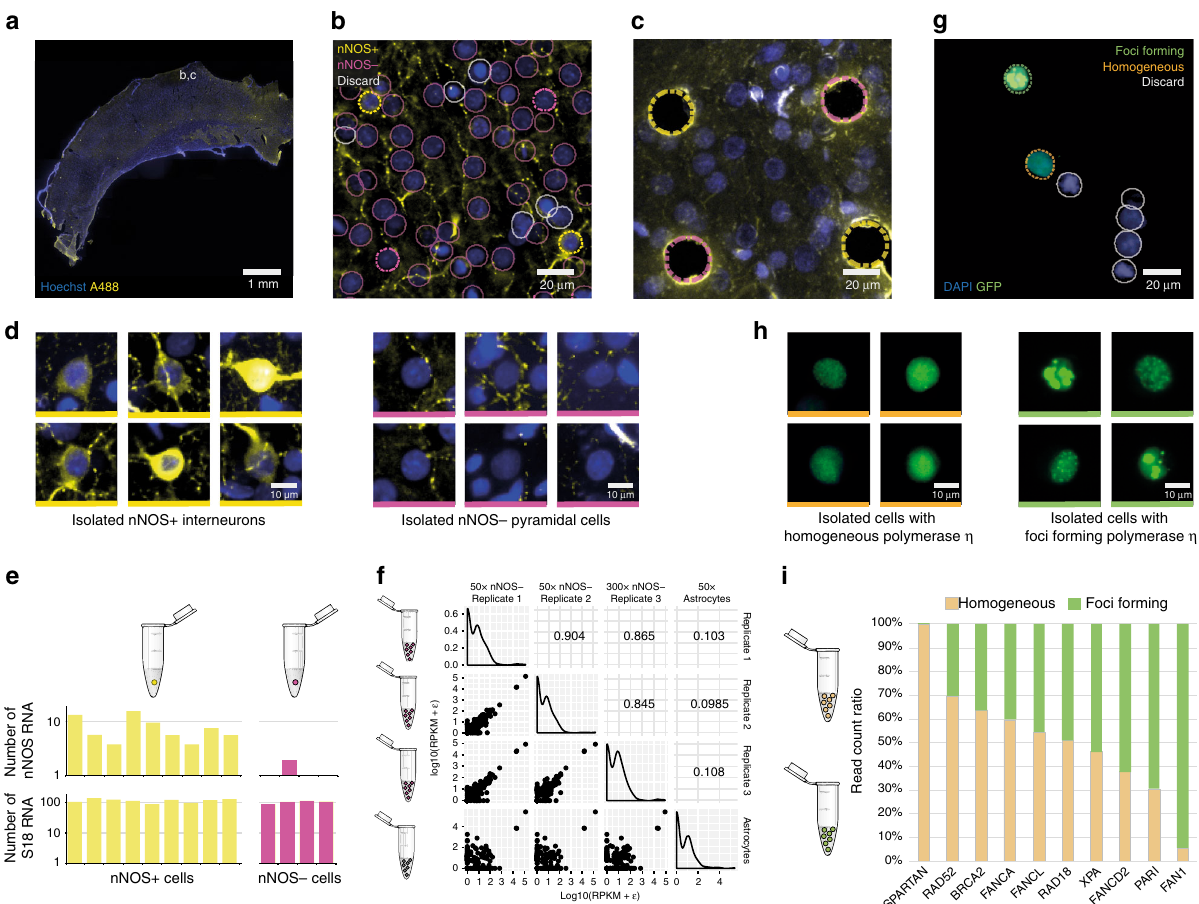
Fig. 2 Computer-assisted microscopy isolation (CAMI) opens the door to new types of high-throughput single-cell molecular analysis through non- disruptive collection of individual cells from fi xed tissue and selection of cells by phenotypic morphology or location. a Coronal sections of rat brain labeled with mouse-anti-NeuN antibody (blue) and rabbit anti-nNOS antibody (yellow) were imaged with a high-throughput microscope. b High-resolution detail of a region of the somatosensory cortex indicated in a . Outlines show nuclear segmentations and phenotype classi fi cations predicted by our software. Cells outlined in yellow are predicted to be nNOS+, cells outlined in magenta are nNOS − , and gray indicates cells that should be discarded (e.g., due to artifacts). Dotted lines indicate cells that were targeted for extraction. c The same region after extracting two nNOS+ and two nNOS − cells. d Individual cells automatically selected and extracted using CAMI, nNOS-expressing interneurons on the left and nonexpressing cells on the right. e Expression levels measured by dPCR show that CAMI reliably separates cells. Cells identi fi ed as nNOS+ show signi fi cantly higher expression (7.96 ± 0.48) than those identi fi ed as nNOS − (0.48 ± 0.95), two-sampled t -test p = 0.0061. Expression levels of housekeeping gene S18 did not vary signi fi cantly between cells identi fi ed as nNOS+ (116.37 ± 16.54) and nNOS − (103.98 ± 10.29), two-sampled t -test p = 0.1992. f Whole-transcriptome gene expression pro fi les of nNOS − cells (two 50-cell replicates and one 300-cell) and astrocytes (50 cells) extracted by CAMI and sequenced by Ion Torrent PGM. Analysis reveals strong correlations (Pearson ’ s R) between the nNOS − replicates, and weak correlations between the astrocytes and nNOS − cells. g CAMI also enables a novel, cost-effective alternative to RNAi screening. Cells with interesting phenotypes are identi fi ed and extracted from mixed populations of stable shRNA- expressing silenced cell lines. After UV exposure, cells normally recruit polymerase η to repair DNA damage, which is visualized as foci by our green fl uorescent marker. Absence of an upstream regulator can disrupt the foci formation and lead to homogeneous polymerase η expression. h CAMI identi fi ed 150 foci-forming and 150 homogeneous cells and extracted them. i Extracted cells were sequenced using next-generation sequencing (NGS). The ratio between the two populations revealed known upstream regulators of polymerase η (BRCA2, RAD18, and SPARTAN) and identi fi ed promising new regulators, Rad52 and